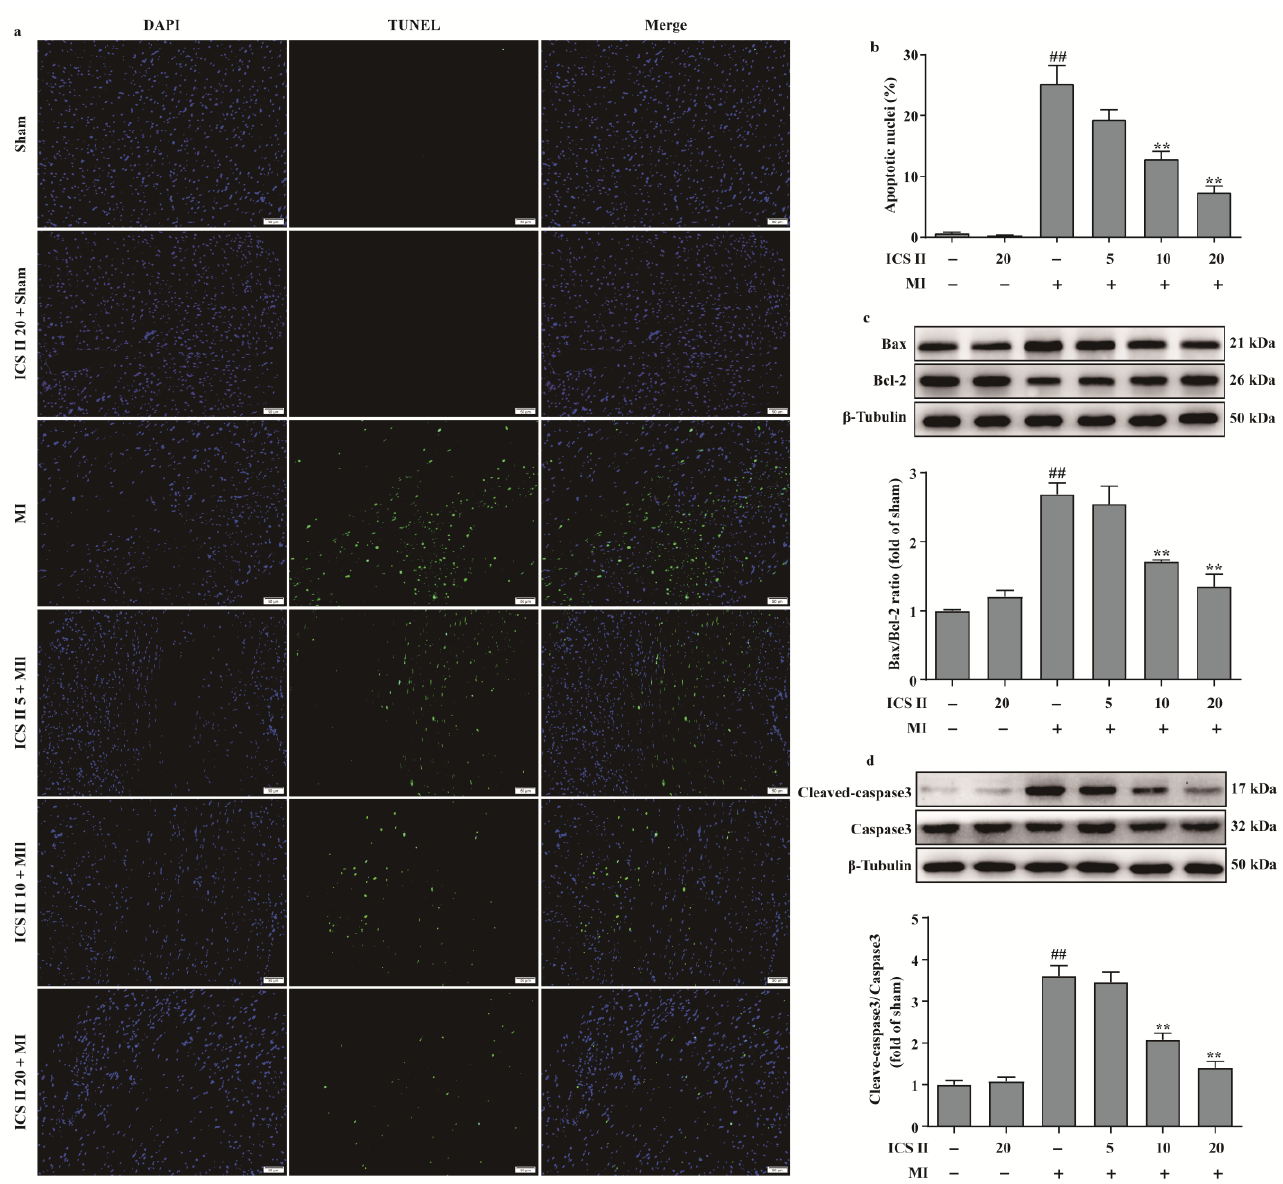
Figure 4. ICS II inhibited myocardial apoptosis in MI-induced mice: ( a ) myocardial apoptosis was assessed using TUNEL staining. Magnification × 200; scale bar, 50 μm ; ( b ) quantitation of TUNEL- positive nuclei (%) in the left ventricle ( n = 5); ( c ) expression of Bax and Bcl-2 and quantitation of Bax/Bcl-2 ratio ( n = 5); ( d ) cleaved-caspase3 level and quantitation ( n = 5). The data are presented as the mean ± SEM. ## p < 0.01 vs. sham; ** p < 0.01 vs. MI.